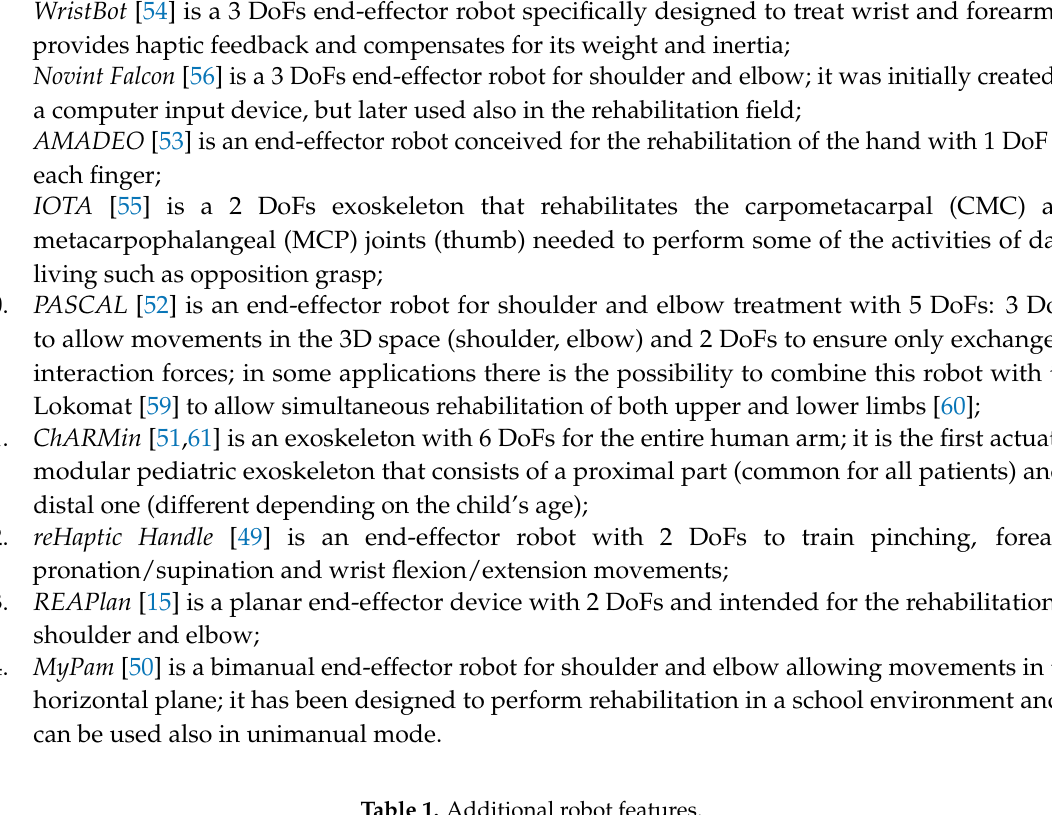
Table 1. Additional robot